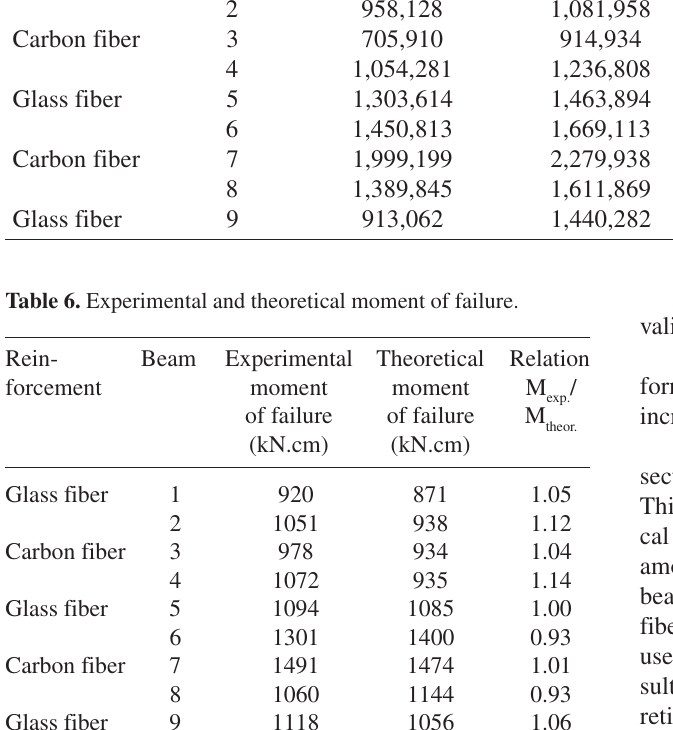
Table 5. Experimental and theoretical values bending stiffness.